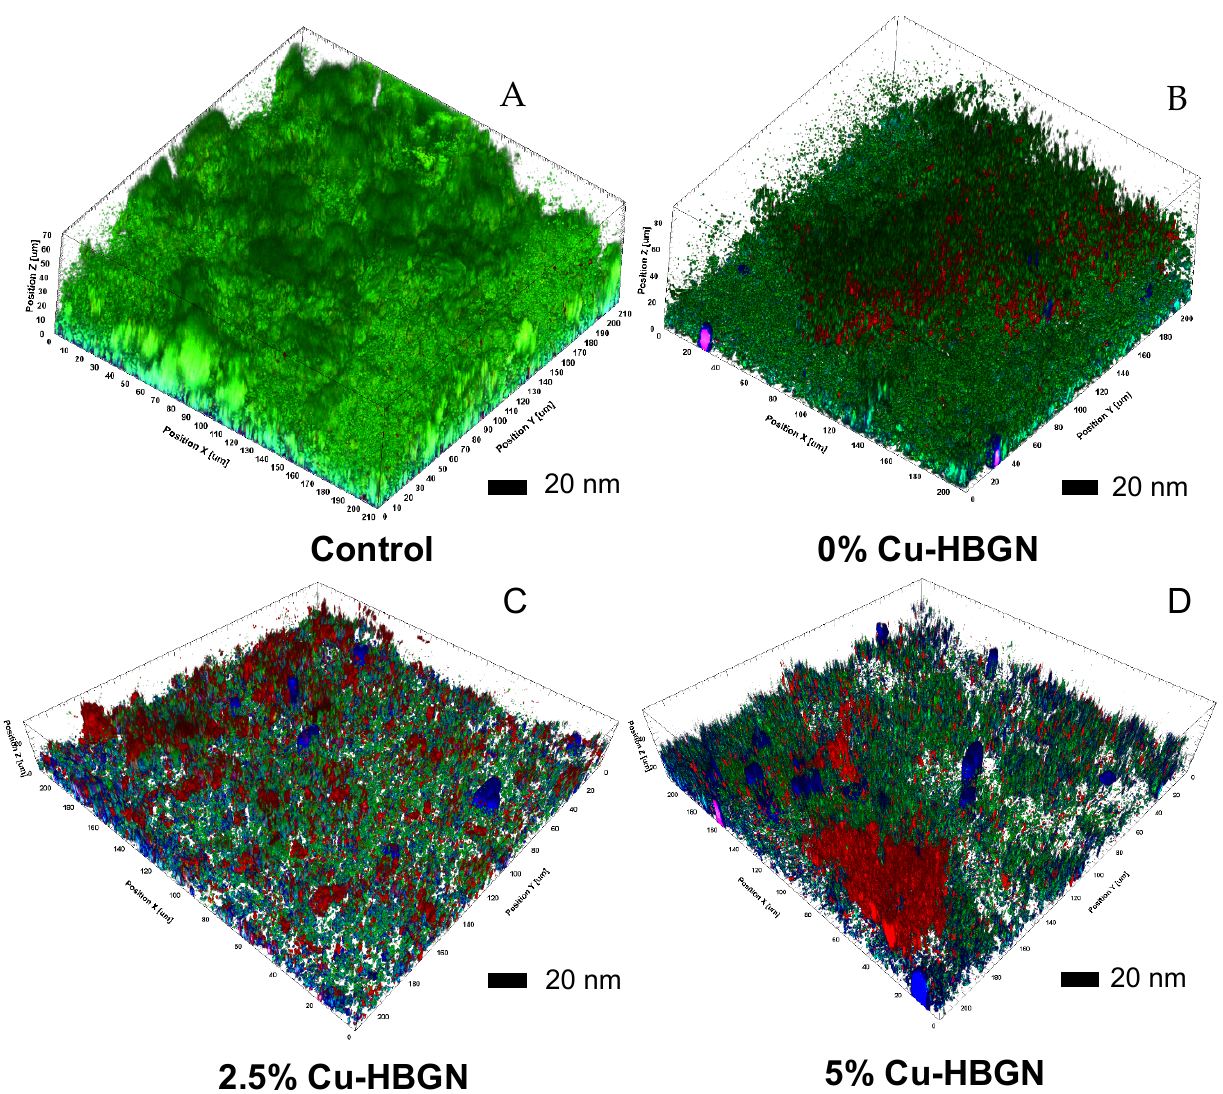
Figure 10. Preformed biofilm of S. aureus stained with BacLight bacteria viability kit. ( A ) Biofilm control. Biofilm treated 24 h of exposure with different compositions loaded with danofloxacin: ( B ) 0% Cu-HBGN, ( C ) 2.5% Cu-HBGN and ( D ) 5% Cu-HBGN.